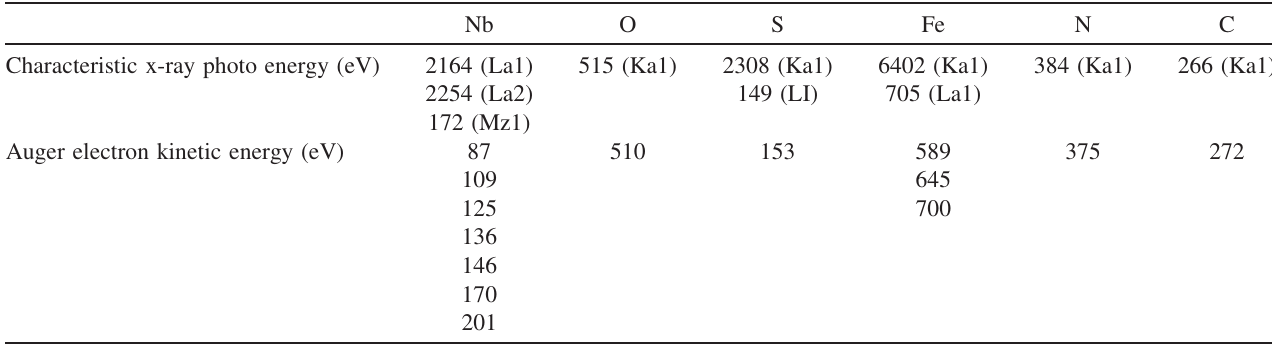
TABLE I. Characteristic x-ray photon energy and Auger electron kinetic energy of some elements.